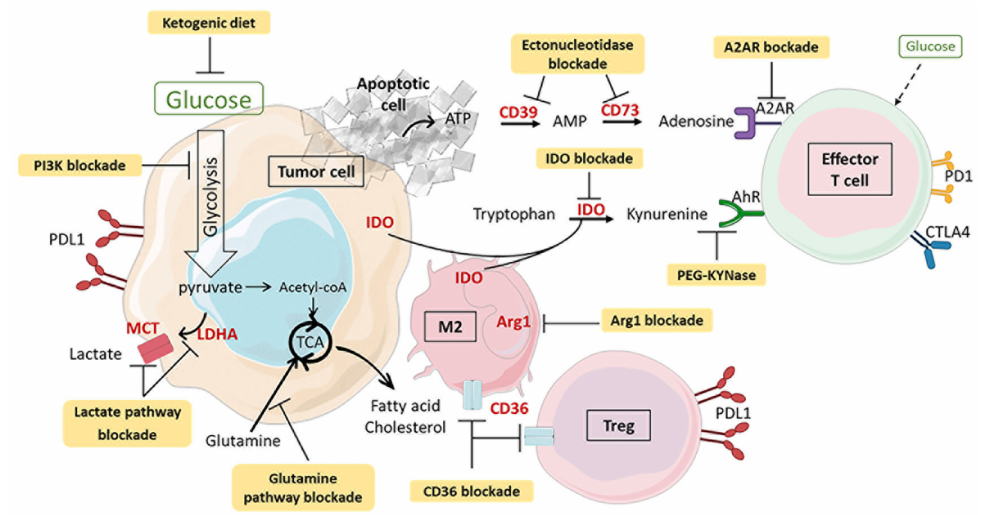
Figure 6. Therapeutic strategies targeting metabolism combined with immunotherapy to enhance the antitumor immune response. The use of small metabolic molecules, antibodies and diet adaptation (in yellow and in bold in the diagram) can modify the metabolic state of the tumor microenvironment (TME). The competition for resources between cancer and immune cells is thus reduced. Tryptophan, arginine, fatty acids and glucose are again available to antitumor immune cells. Targeting of the indolamine 2,3-dioxygenase (IDO), lactate and adenosine pathways prevents deleterious metabolites from suppressing the immune response against cancer. These strategies, which synergize with immunotherapy, must be adapted to the type and stage of cancer and to the interindividual vari- ability of drug response. AhR: aryl hydrocarbon receptor; AMP: adenosine monophosphate; Arg1: arginase 1; ATP: adenosine triphosphate; CTLA4: cytotoxic T lymphocyte antigen 4; IDO: indolamine 2,3-dioxygenase; M1: macrophage 1; M2: macrophage 2; MHC: major histocompatibility complex; PD1: programmed cell death protein 1; PDL1: programmed cell death ligand protein 1; TME: tumor